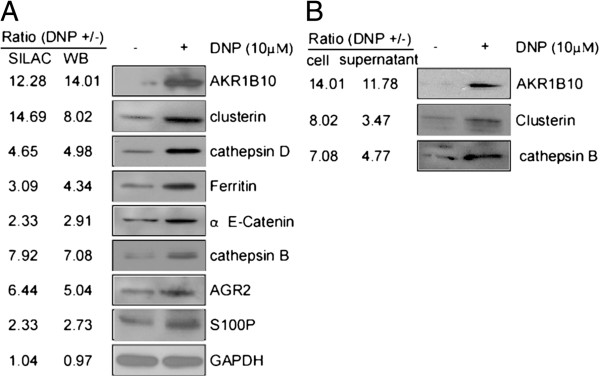
Differential protein expression confirmed using Western blotting.A, eight representative proteins, aldo-keto reductase (AKR) 1B10, clusterin, cathepsin B, cathepsin D, ferritin, α-E-catenin, AGR2, and S100P were detected in 6-10B cells with or without DNP treatment using Western blotting. GAPDH served as a loading control. The relative photographic density was quantitated using a gel documentation and analysis system. B, AKR1B10, Cathepsin B and Clusterin were detected in the cell culture supernatant of 6-10B cells with or without DNP treatment using Western blotting. WB, Western blotting. SILAC, stable isotope labeling with amino acids in cell culture.